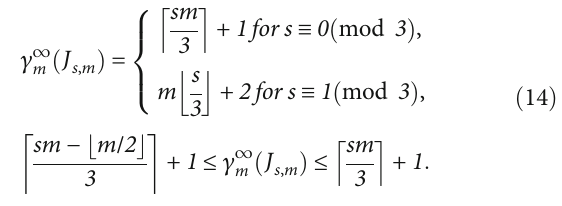
ð J Þ = m b s /3 c + 2 = 10 7,4 m